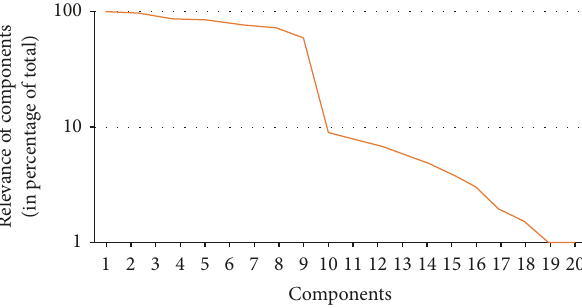
Figure 2: Representative example of the sorted PCA eigenvalue. The 𝑥 -axis shows the values of the component as a percentage of the total in log